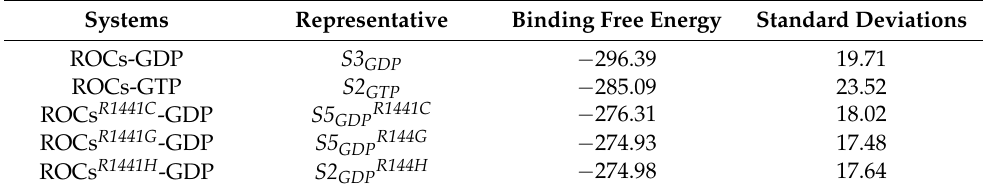
Table 1. ROC monomers MM/PBSA-binding free energy (kcal/mol)